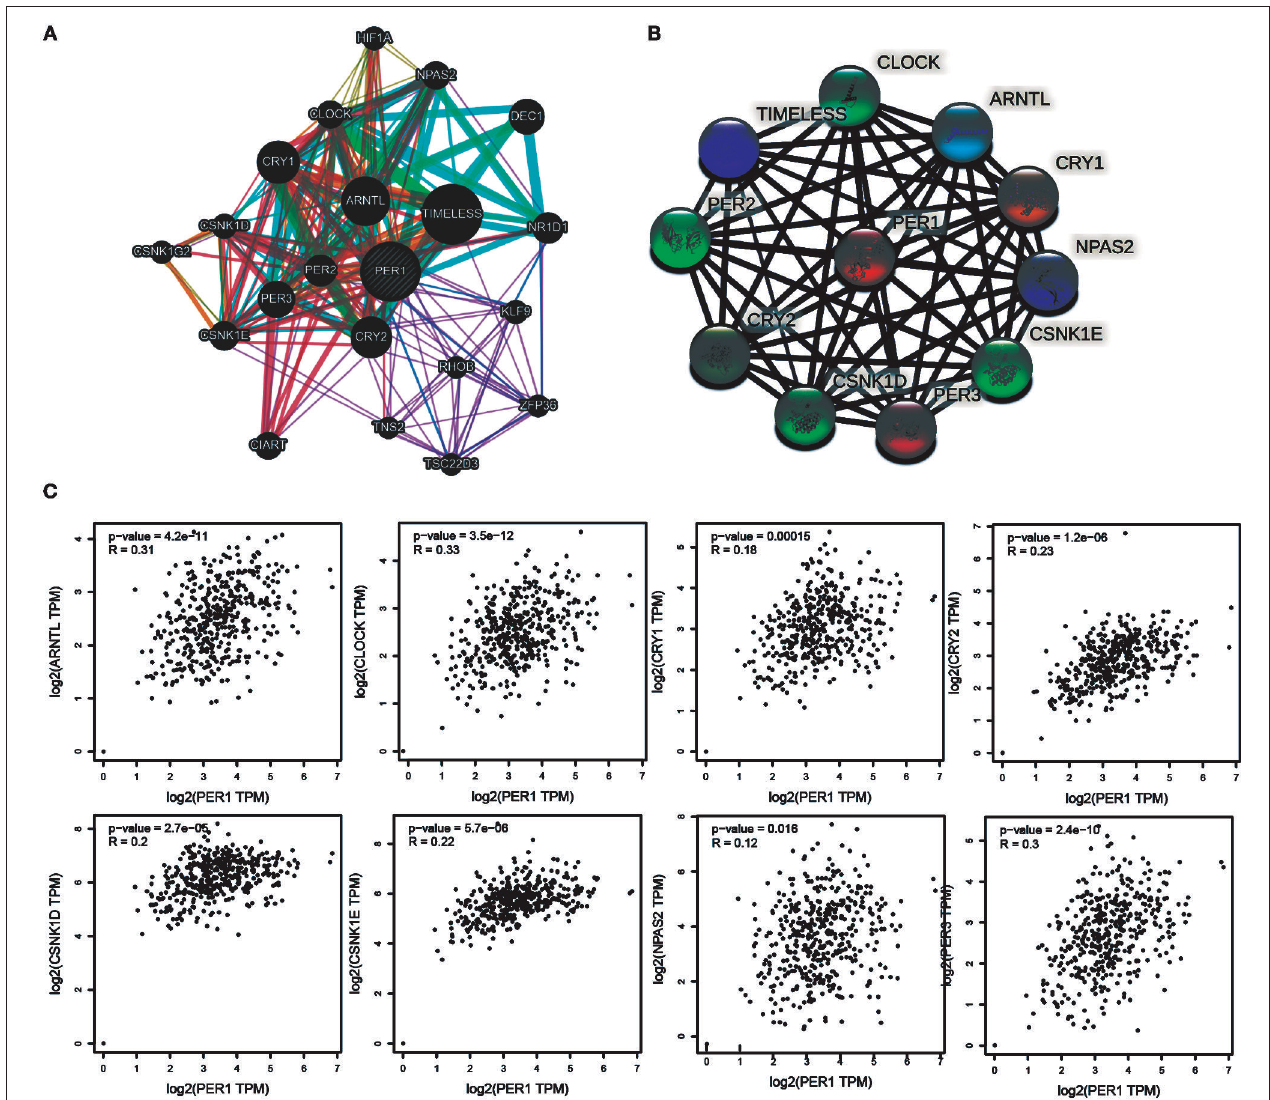
FIGURE 4 | Interaction analysis for PER1 at the gene and protein levels. (A) Gene–gene interaction network for PER1 constructed using the GeneMANIA. The 24 most frequently changed neighboring genes are shown. Each node represents a gene. The node color represents the possible functions of the respective gene. (B) PPI network containing 10 nodes, constructed using the STRING database. (C) Scatter plots of correlations between PER1 expression and ARNTL, CLOCK, CRY1, CRY2, CSNK1D, CSNK1E, NPAS2, and PER3 in OV.